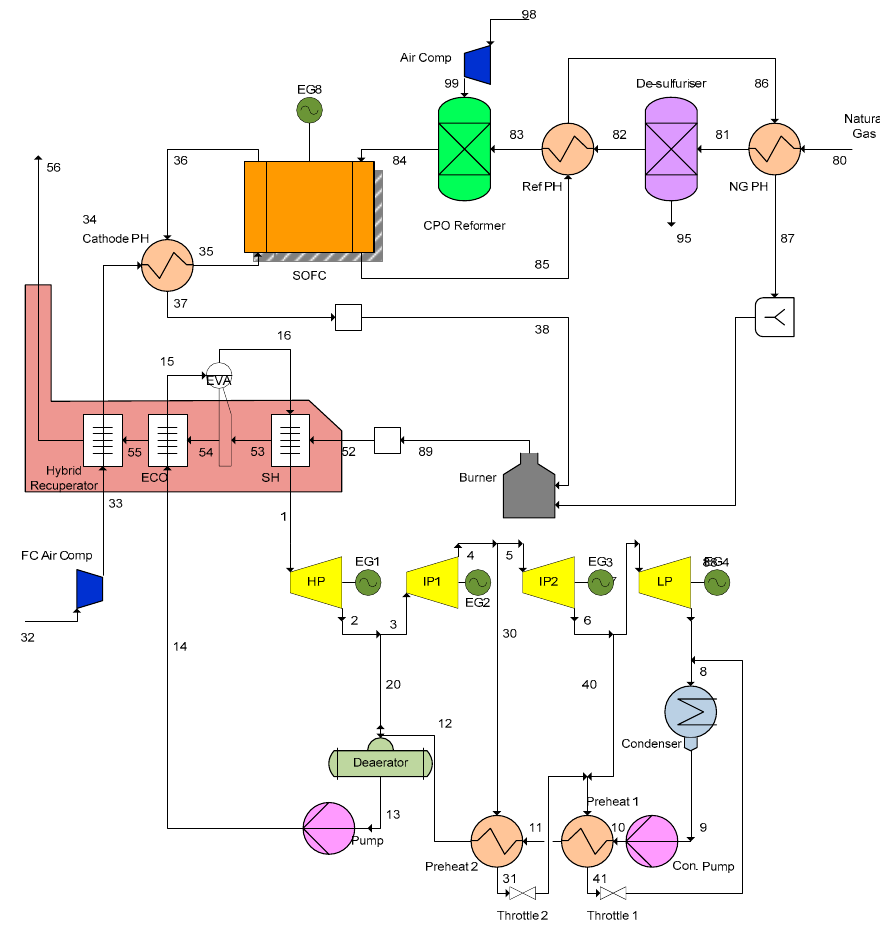
Figure 4. Natural gas fired SOFC—steam hybrid plant.